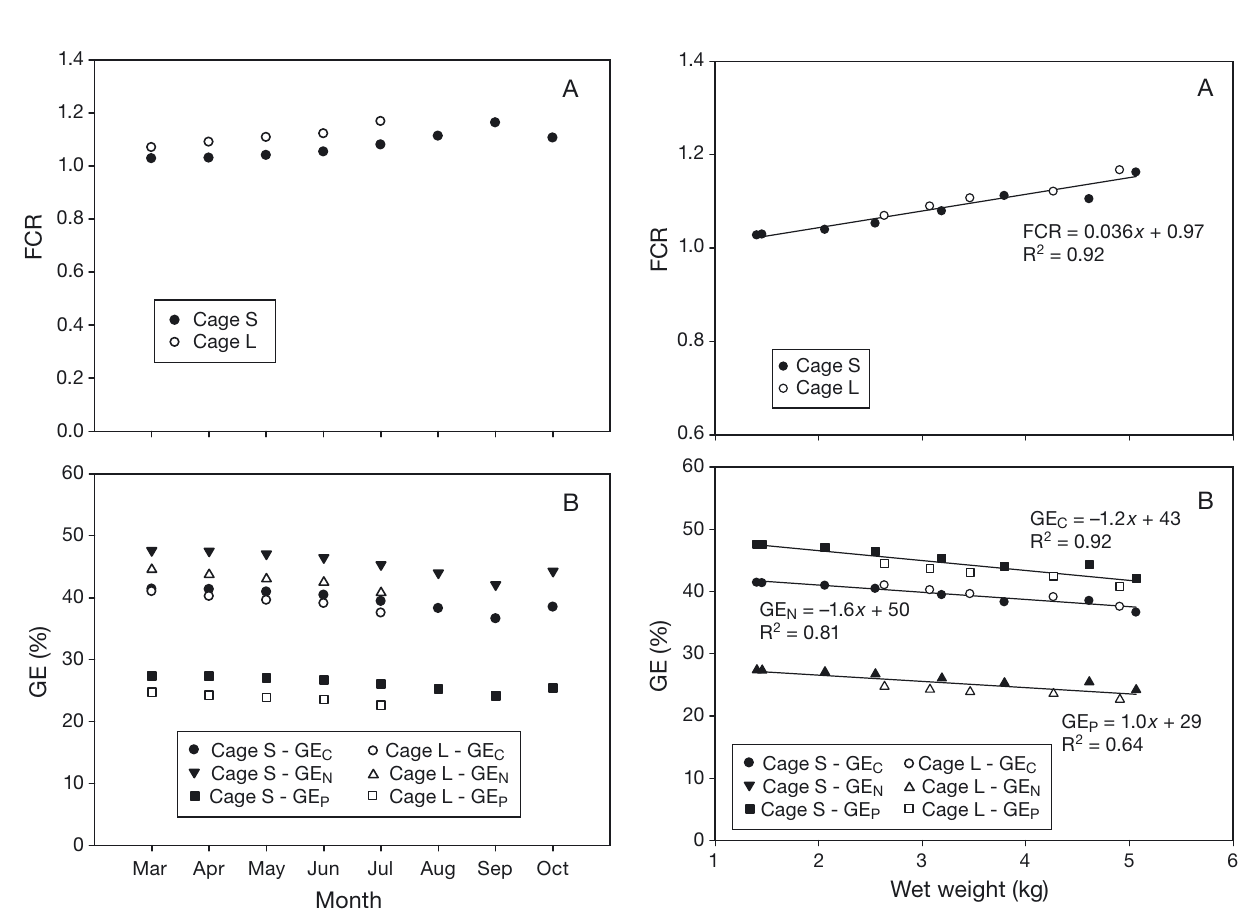
Fig. 3. (A) Relationship between feed conversion ratio (FCR) Fig. 2. (A) Feed conversion ratio (FCR) and (B) growth effi- and fish wet weight. (B) Relationship between growth effi- ciency (GE) of C, N and P for Cage S and Cage L for each ciencies (GE of C, N and P) and fish wet weight. Fish were month. FCR was expressed in terms of feed use (dry weight) sampled from Cage S and Cage L (n = 13). Solid lines are per fish produced (wet weight). GE was estimated for C, N regression and P and was expressed as fish C, N and P produced per C, N and P consumed, respectively